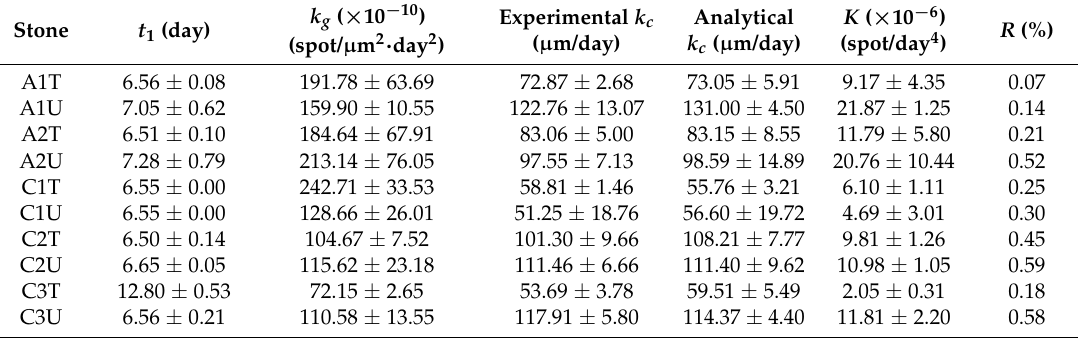
Table 2. Experimental and calculated Avrami’s parameters with standard deviations ( ± ), and confidential R factor. The simulated biofouling was concordant with real colonization when R is at its minimum (or